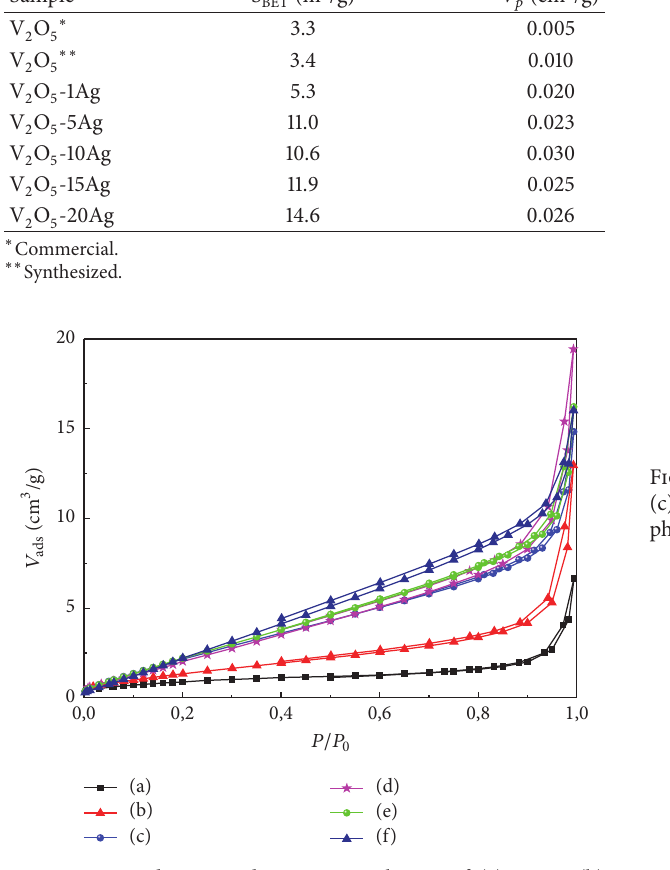
Figure 3: N 2 adsorption-desorption isotherms of (a) V 2 O 5 , (b) V 2 O 5 -1Ag, (c) V 2 O 5 -5Ag, (d) V 2 O 5 -10Ag, (e) V 2 O 5 -15Ag, and (f) V 2 O 5 -20Ag.